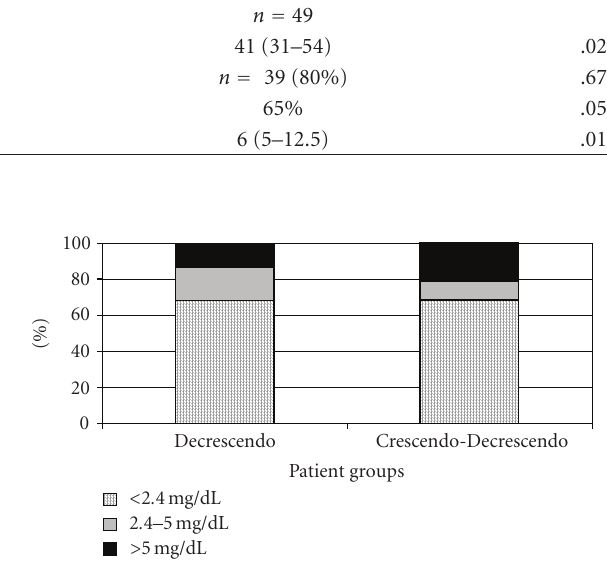
Figure 2: Stratification of admission bilirubin levels based on likelihood of ampullary obstruction. Bilirubin levels < 2.4 mg/dL (unlikely), bilirubin levels 2.4–5 mg/dL (possible), bilirubin levels > 5mg/dL (likely). Depicted as percentage contribution of each category in each group. No di ff erences were noted between patients in the Decrescendo group compared to the Crescendo-Decrescendo group ( P = .